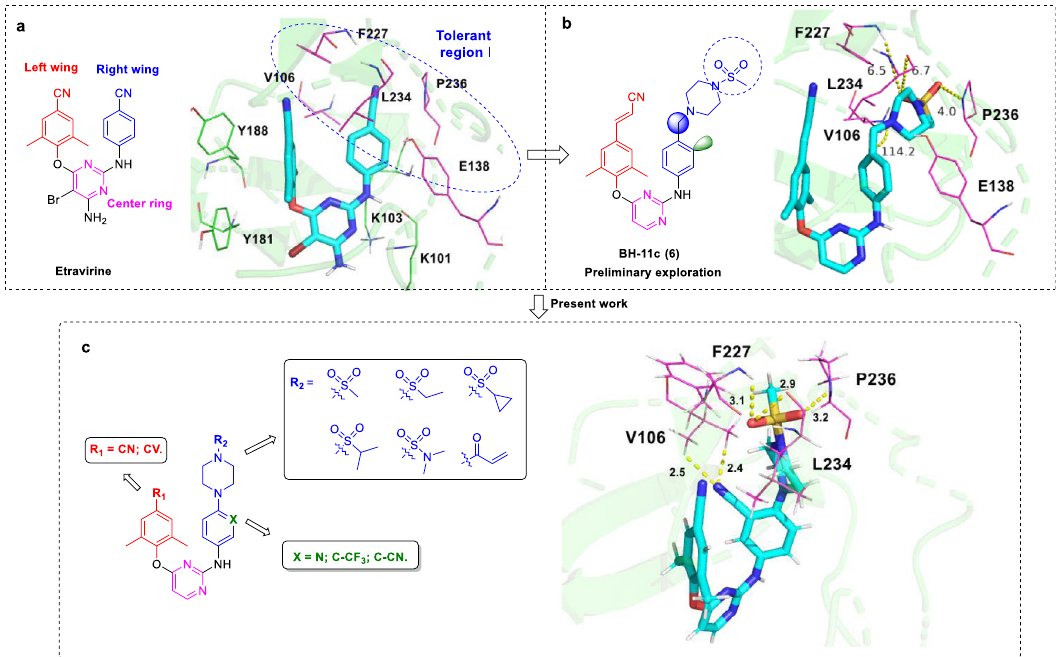
Fig. 2 Design and optimization of DAPY-typed HIV-1 NNRTIs targeting the main chains of the residues in tolerant region I. a The cocrystal structure of ETR/RT (PDB code: 3MEC). b Predicted binding mode of BH-11c bound to the NNIBP (PDB code: 3MEC). c Predicted binding mode of newly designed representative compound 18a1 bound to the NNIBP (PDB code: 3MEC). The docking was performed using the Sur fl ex-Dock of SYBYL-X 2.0, and the results were shown by PyMOL (http://www.pymol.org/). The distance between ligands and residues is indicated by dashed line. The bond angle is indicated by an arc dashed line.